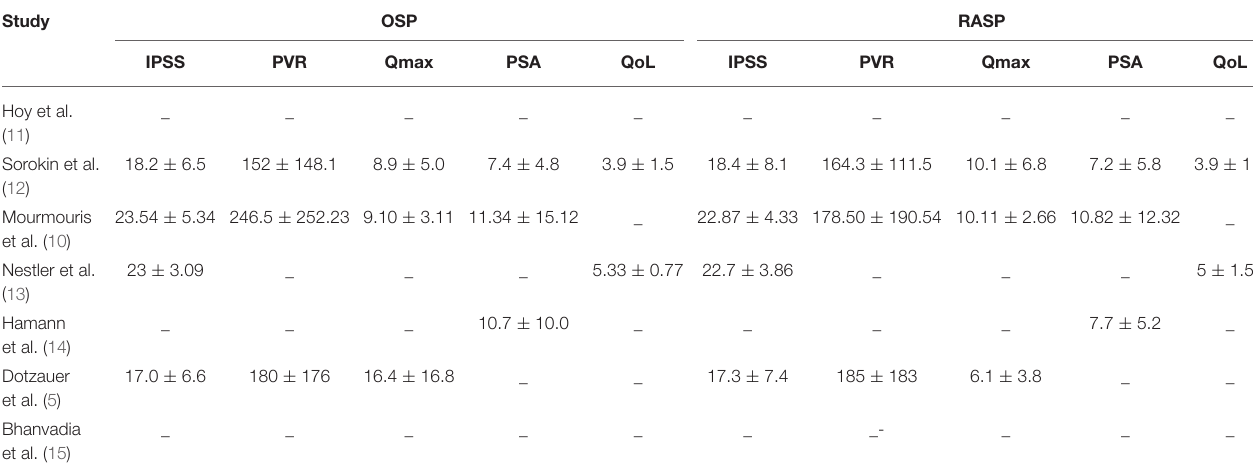
TABLE 2 | Pre-operative parameters of included studies in the meta-analysis. Study